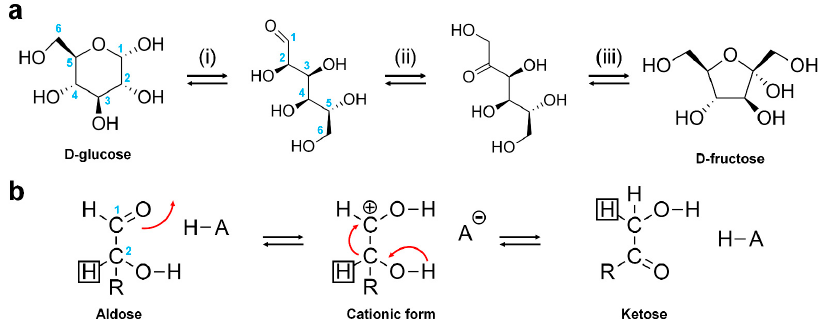
Figure 2. Isomerization mechanism of GI. ( a ) Three major steps involved in the configuration change from D ‐ glucose to D ‐ fructose catalyzed by GI. ( b ) Hydride shift mechanism of GI.